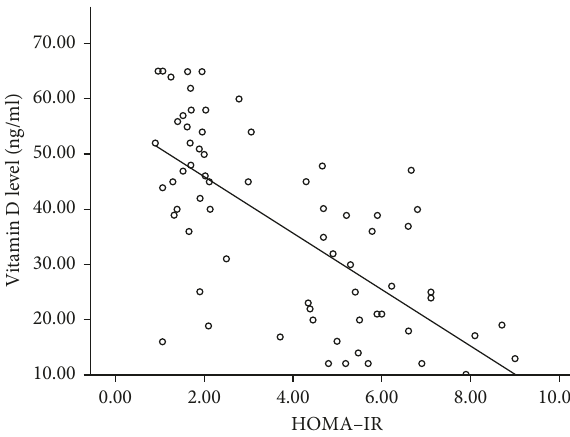
Figure 6: Relation between HOMA-IR and vitamin D. Table 8: Relation of HOMA-IR with vitamin D anti-TG and anti-TPO levels. Vitamin D level